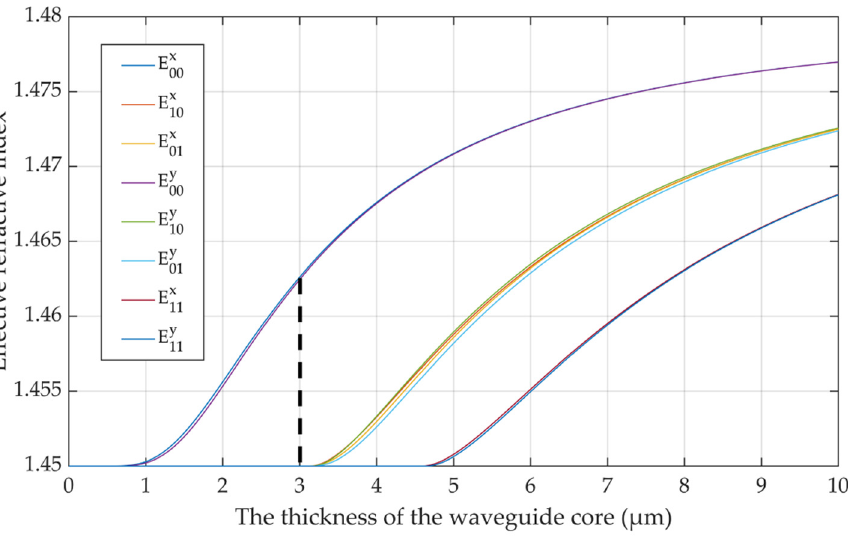
Figure 2. Single-mode condition curve. Dashed line indicates: 3 × 3 µm is the maximum size to ensure single-mode transmission.